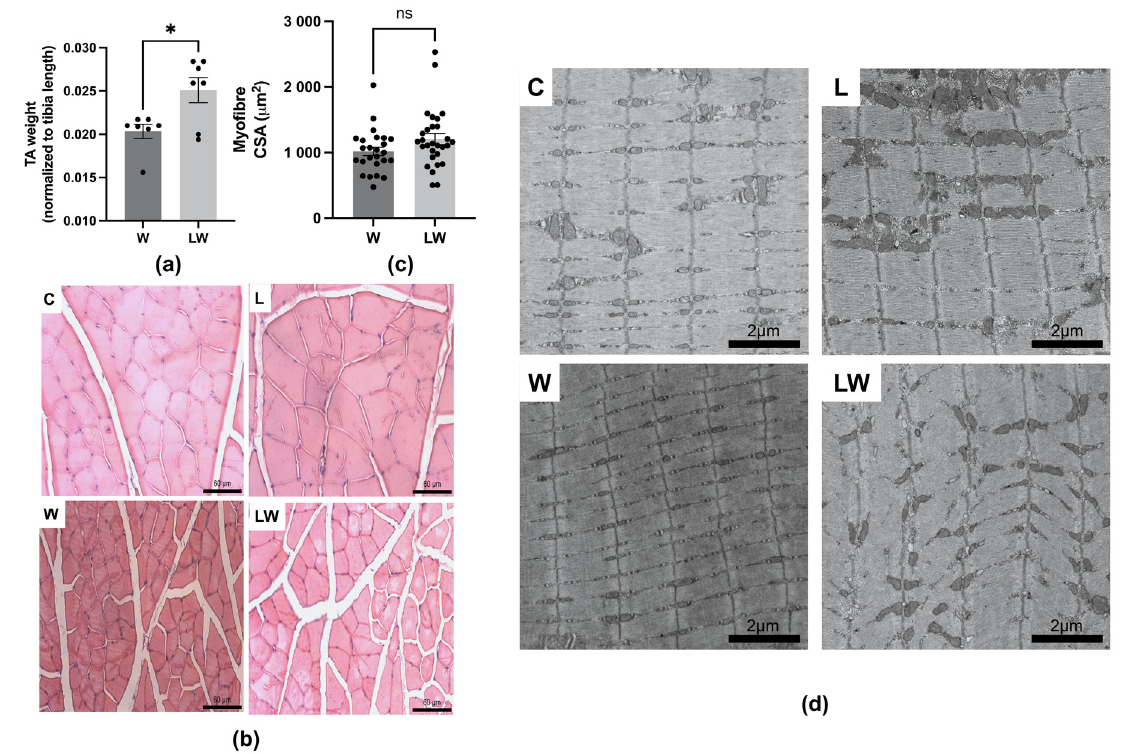
Figure 5. Morphometric, histological and ultrastructural analyses of tibialis anterior muscle among the different experi- mental groups. ( a) Tibialis anterior (TA) muscle mass (normalised by the respective tibia length). ( b ) Representative light microscopy of muscle tissue cross-section, stained by Hematoxylin Eosin, in C, L, W and LW groups (Scale bar: 60 µ m. Magnification 40 × ). ( c ) Measurements of myofibre cross-sectional area ( µ m 2 ). ( d ) Representative transmission electron microscopy of myofibre showing sarcomeric arrangement and mitochondria distribution at cytoplasm in C, L, W and LW groups (Scale bar: 2 µ m. Magnification at 10,000 × ). For details, see the Methods section. N = 6 animals per group. Graphics represent mean ± SEM. * p < 0.05 and ns = not significant by t -test.